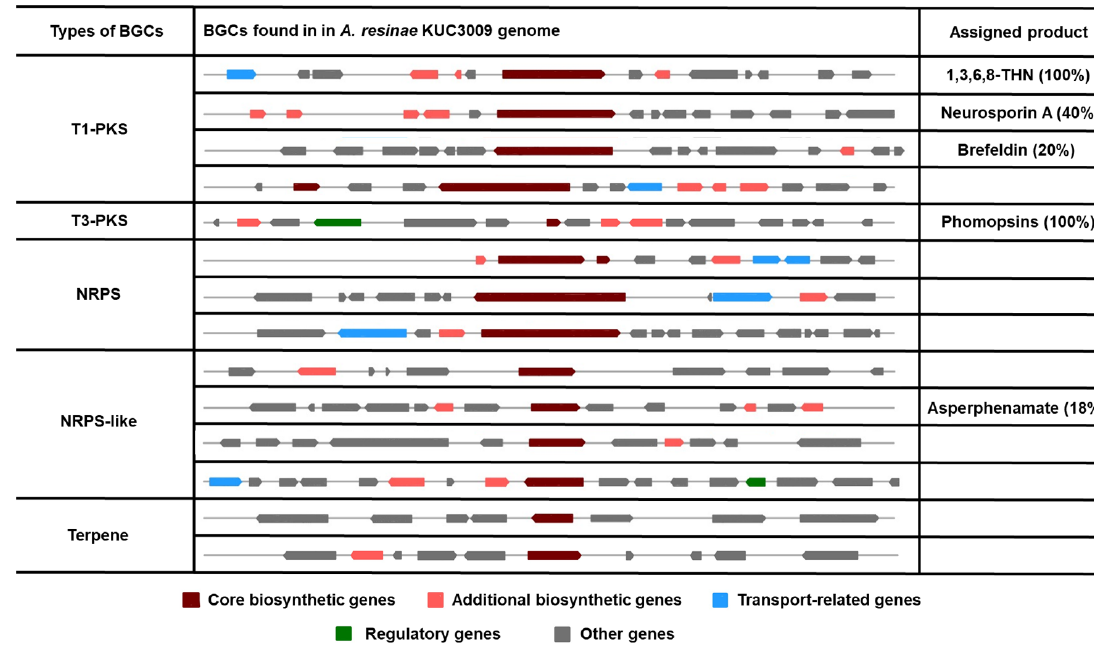
Figure 3. All identified biosynthetic gene clusters (BGCs) in the genome of A. resinae KUC3009 and their predicted assigned product. Values in parentheses indicate the similarity with a known cluster.